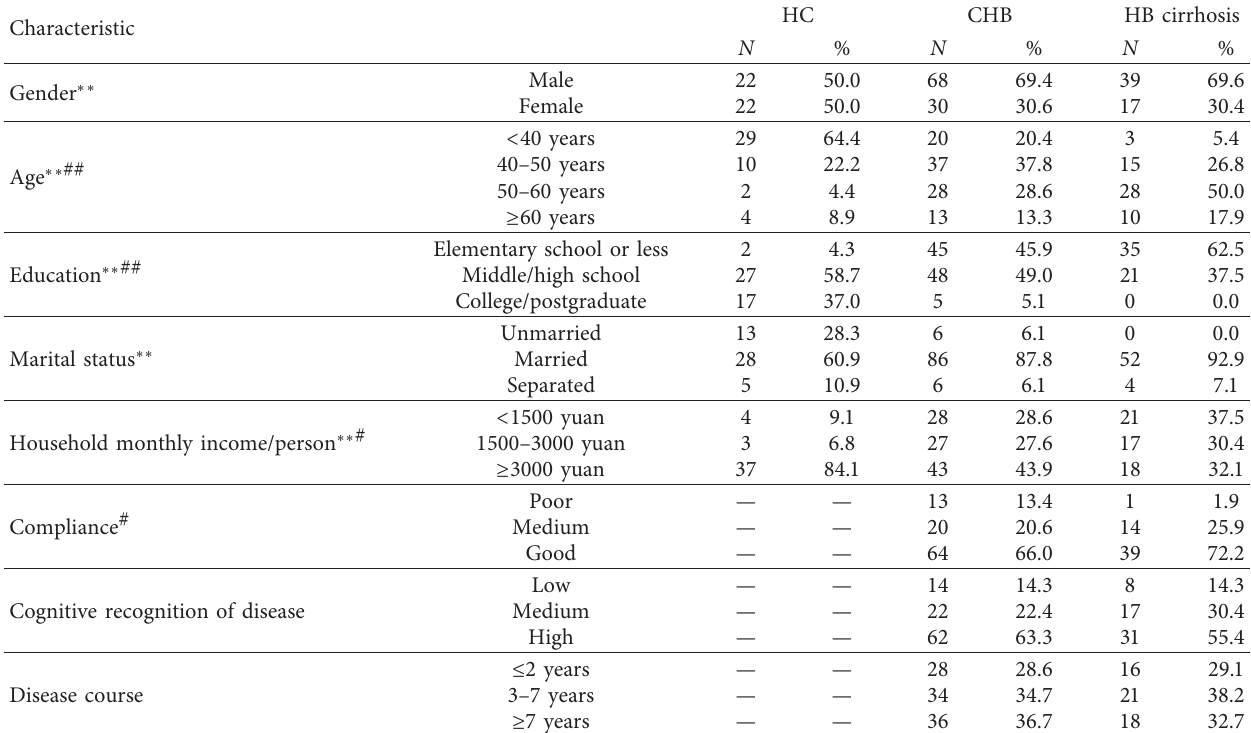
Table 1: Sociodemographic characteristics and clinical parameters of the respondents (because some respondents did not answer all questions, the numbers of valid responses for characteristics differ). Characteristic